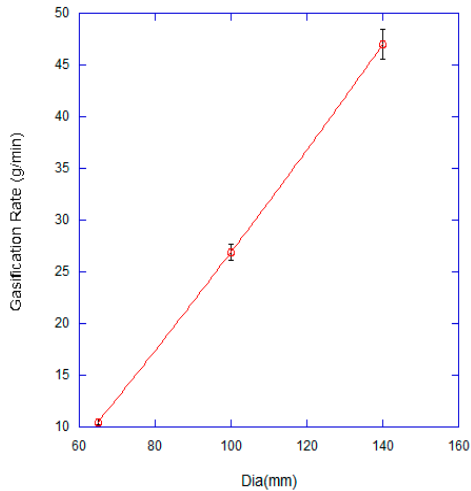
Figure 9. Variation of gasification rate with diameter.